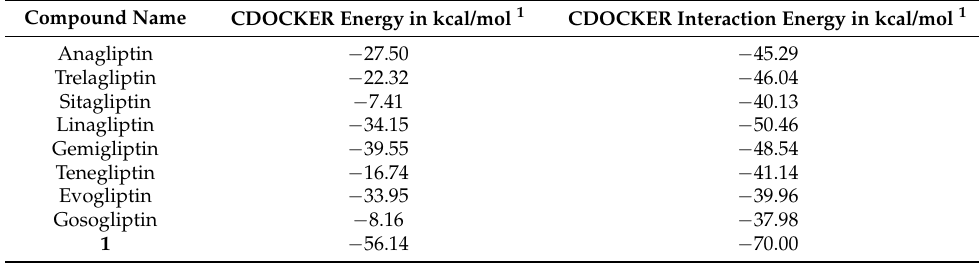
Figure 2. Comparison of binding mode of peptidomimetic inhibitor 1 (stick cartoon, blue color) in the SARS-CoV-2 M pro protomer (PDB ID: 6Y2F) obtained using the CDOCKER docking algorithm with the crystal structure of 1 (stick cartoon, green color). Hydrogen atoms are not shown to enhance clarity. Table 1. CDOCKER Energy and CDOCKER Interaction Energy data for DPP4 inhibitors in the SARS-CoV-2 M pro protomer.